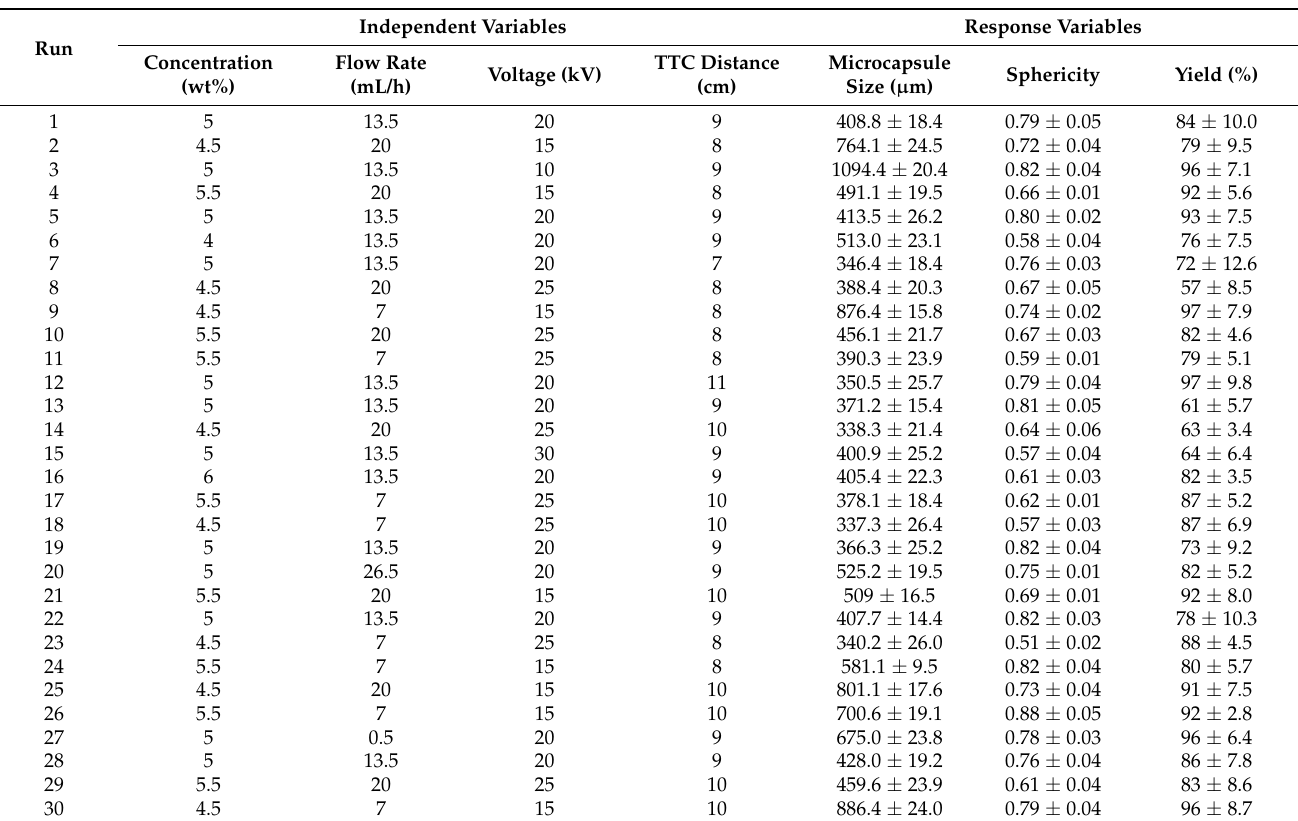
Table 2. Experimental design for chitosan microcapsules with independent variables and experimen- tal values of